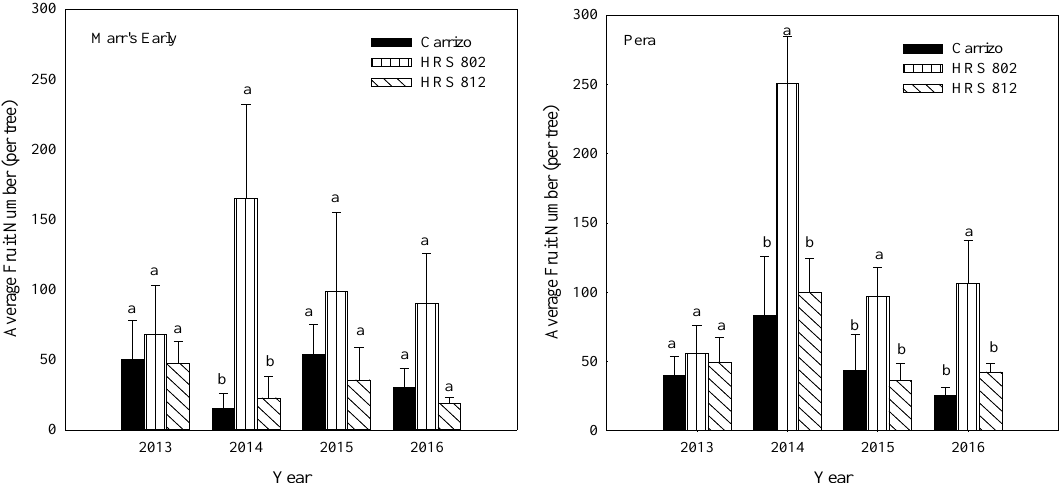
Figure 3. Total average fruit number (2013–2016) of ‘Marr’s Early’ and ‘Pera’ sweet oranges grafted on three different rootstocks growing in Alonso clay series soil at the Agricultural Experiment Substation of Adjuntas, Puerto Rico. Means ± standard error with the different letters for each scion and year are not significantly different by Tukey’s test at α < 0.05.